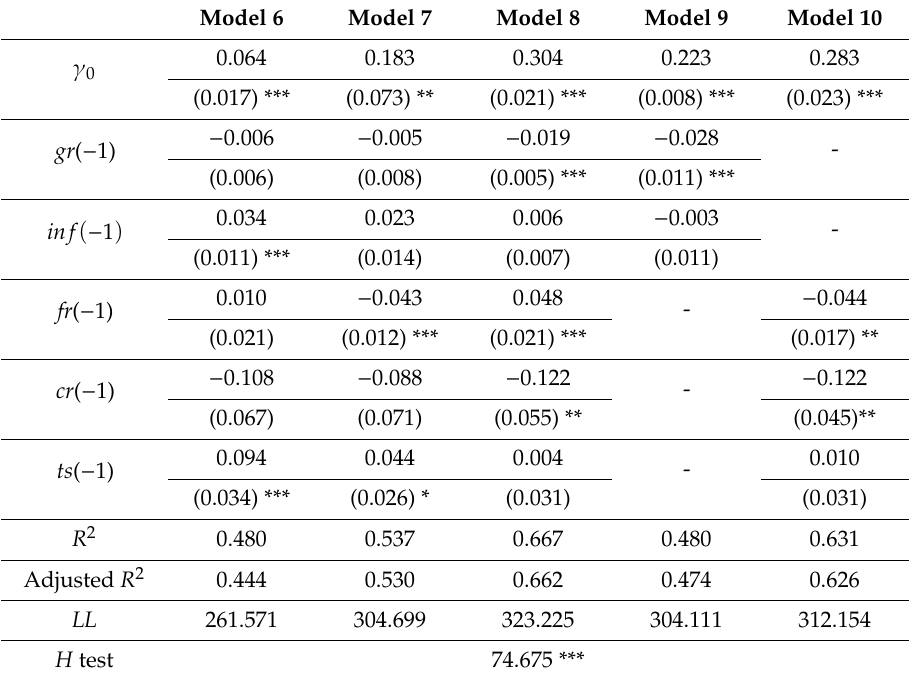
Table 7. Estimation results for panel data